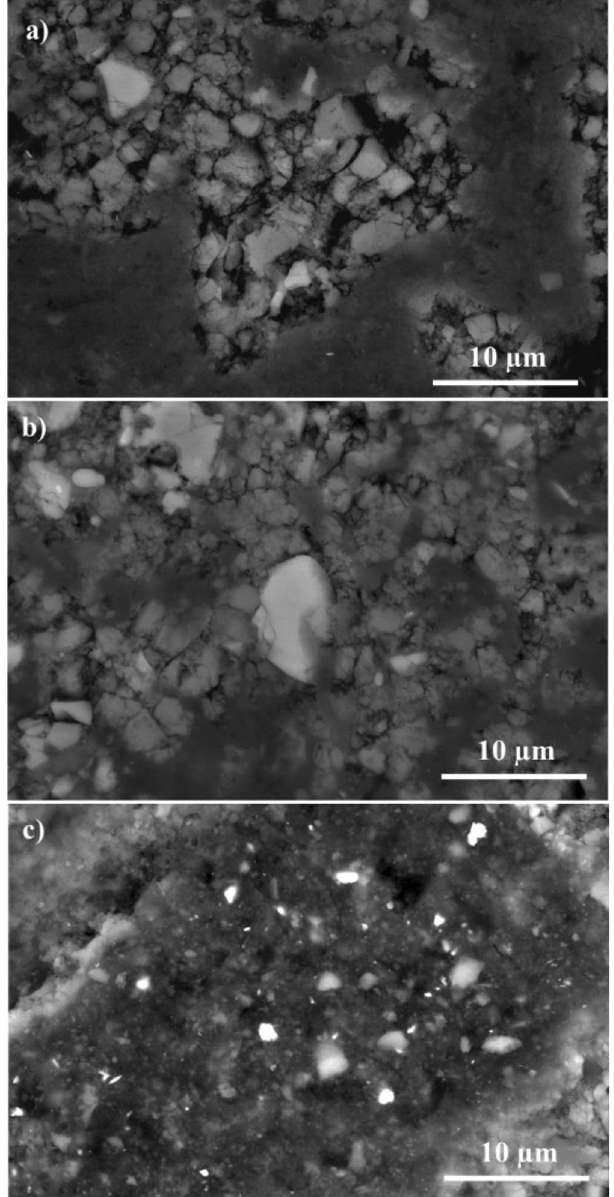
Figure 8. FESEM photomicrographs of the hydrated CA60 cement samples fired at 1450 °C; ( a ) after 1 day, ( b ) after 3 days, ( c ) after 7